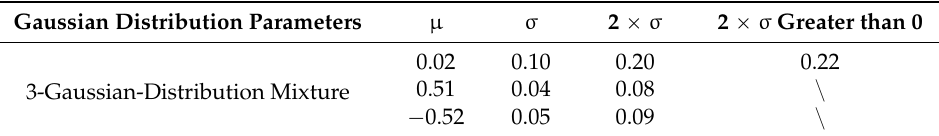
Table 4. The average statistical summary of the MSSI distribution for all the image data. Table 5. The average statistical summary of the MSSI distribution for all the image